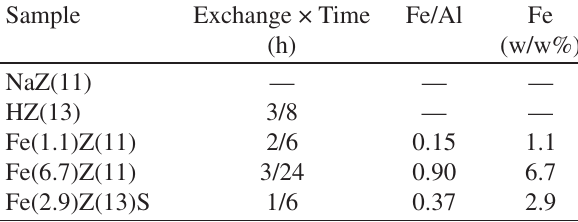
Table 2. Characteristics of the prepared Fe/ZSM-5 catalysts. Sample